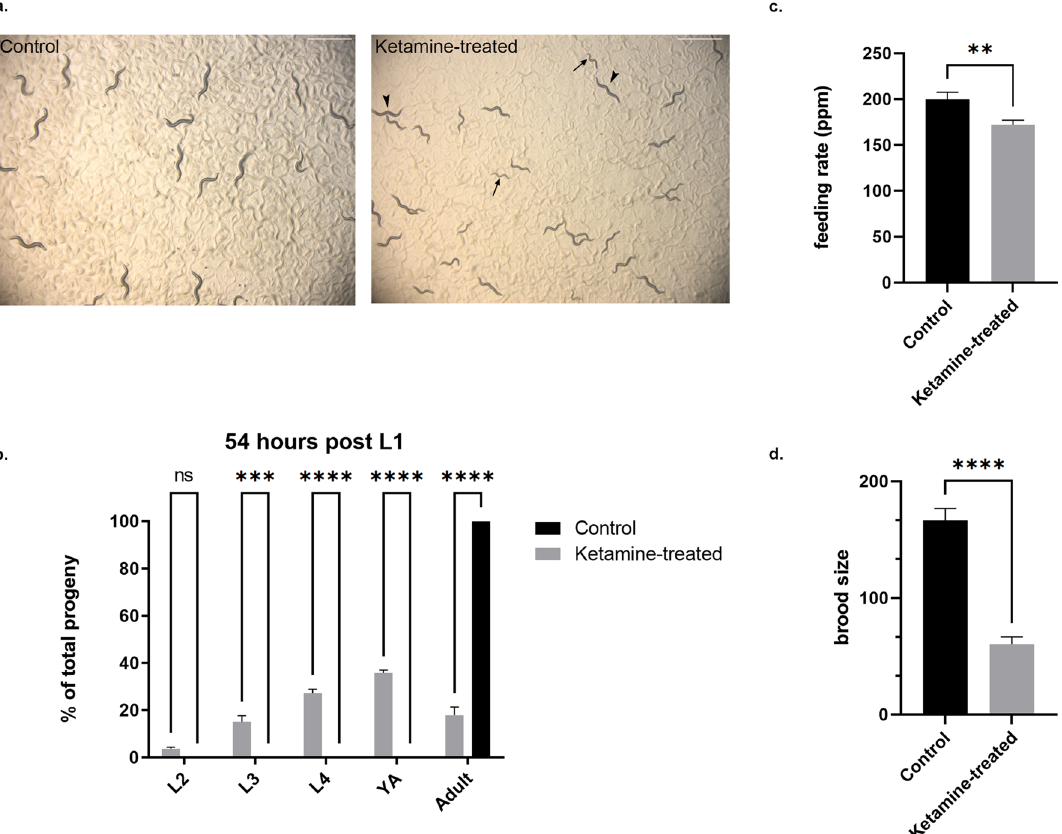
Figure 1. Ketamine-treated animals display stochastic development with slower pumping rate and reduced brood size ( a ) Control and ketamine-treated wild-type animals at 54 h post L1 is shown. In the control plate, all animals reach adulthood 54 h post L1 stage whereas in ketamine-treated plate mixed stage animals were observed as indicated with arrows showing L2 stage animals and arrowheads adults. Scale bar indicates 1 mm. ( b ) Worms grown in 2.5 mM ketamine (n = 1036) showed stochastic growth consisting of L2, L3, L4, young adult and egg-laying adult at 54 h post L1 whereas 100% of the control animals (n = 958) reached egg-laying adult stage. (Two-way ANOVA with Šídák’s multiple comparisons test, mean ± sem, *** p < 0.001, **** p < 0.0001) ( c ) pharyngeal pumping rate per minute (ppm) was measured for control (n = 26) and ketamine-treated animals (n = 26), p = 0.0048. (Student’s t -test, unpaired, mean ± sem, ** p < 0.01) ( d ) The brood size of control (n = 30) and ketamine-treated animals (n = 25) were measured until egg-laying ceased. (Student’s t -test, unpaired, mean ± sem, **** p <